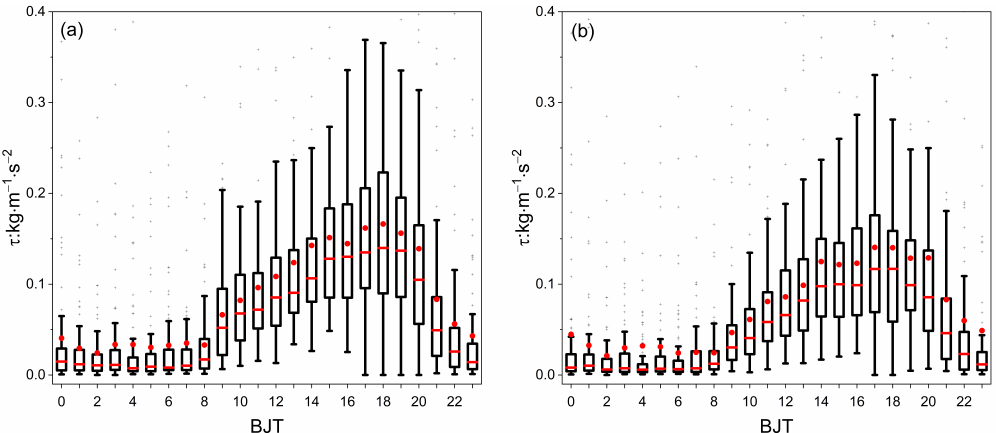
Figure 1. Cont . Figure 7. Diurnal variation of momentum flux in the PV plant ( a ) and the reference site ( b ). The height of the box shows the range from the 25th to 75th percentile. The horizontal red line inside the box and the solid red dot denote the median value and mean value, respectively. The ends of the whiskers were drawn to the 10th and 90th percentile